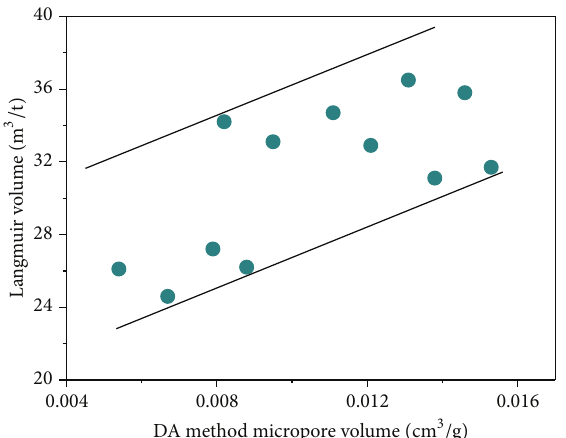
Figure 10: Relationship between the Langmuir volume and the micropore volume as determined by the DA method.